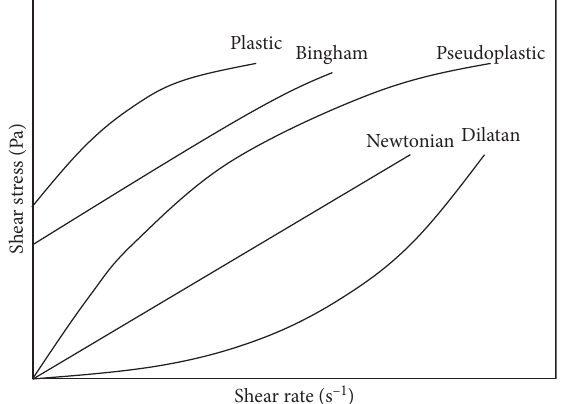
Figure 2: Flow curves or rheograms representing the rheological behaviour of different flow types (after